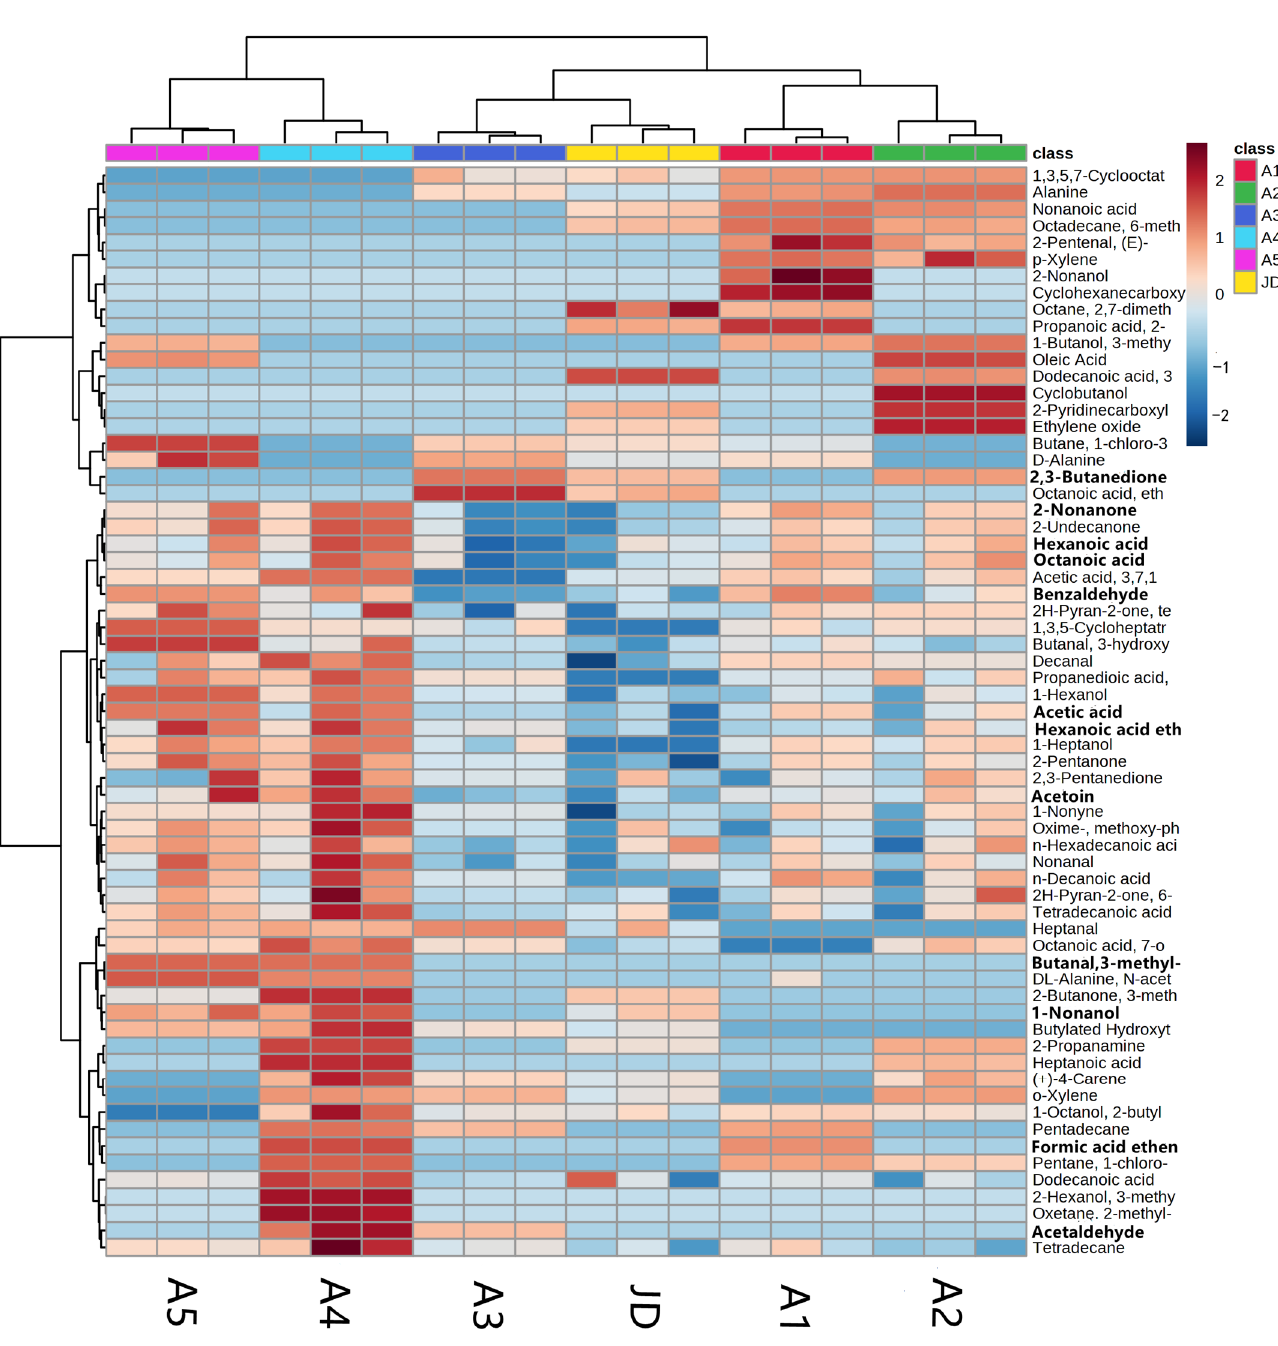
Figure 3. Heatmap of volatile flavour compounds in all samples and the control. The metric of the x-axis is five different ratios of L. delbrueckii subsp. bulgaricus IMAU20312 and S. thermophilus IMAU80809 in starter cultures and the commercial starter culture control, and the y-axis is the concentration of volatile flavour compounds in all samples and the control (JD).